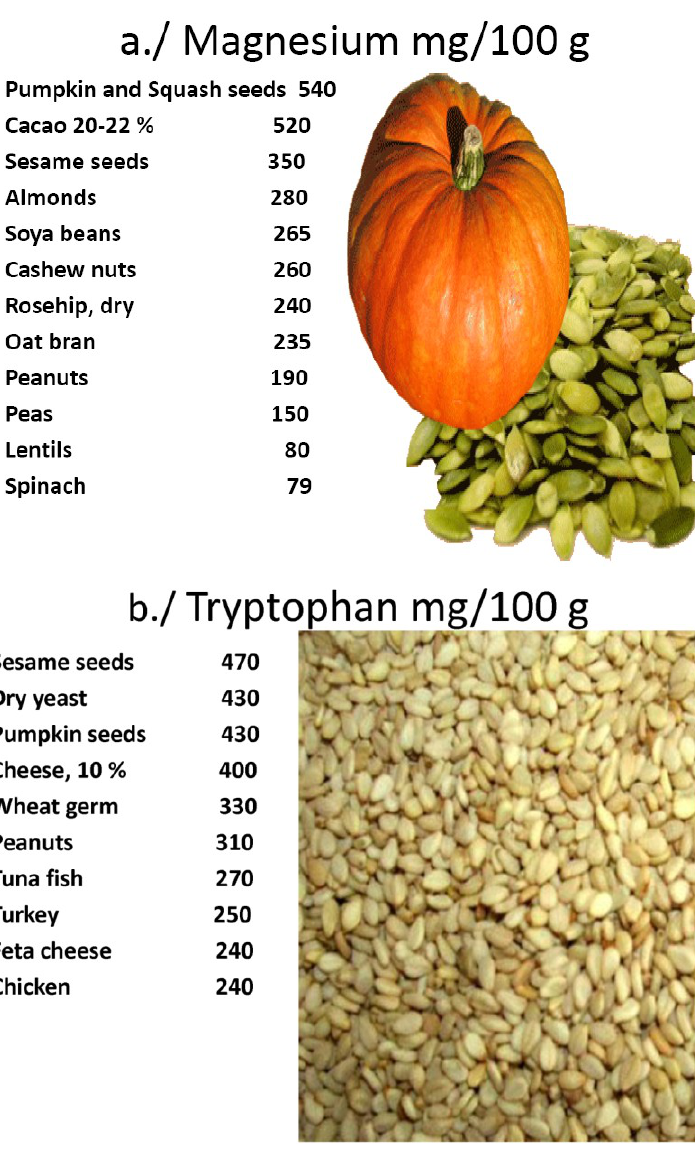
Figure 3. Examples of foods rich in key nutrients, which might be tried in future nutrition solutions both for healthy and critically ill